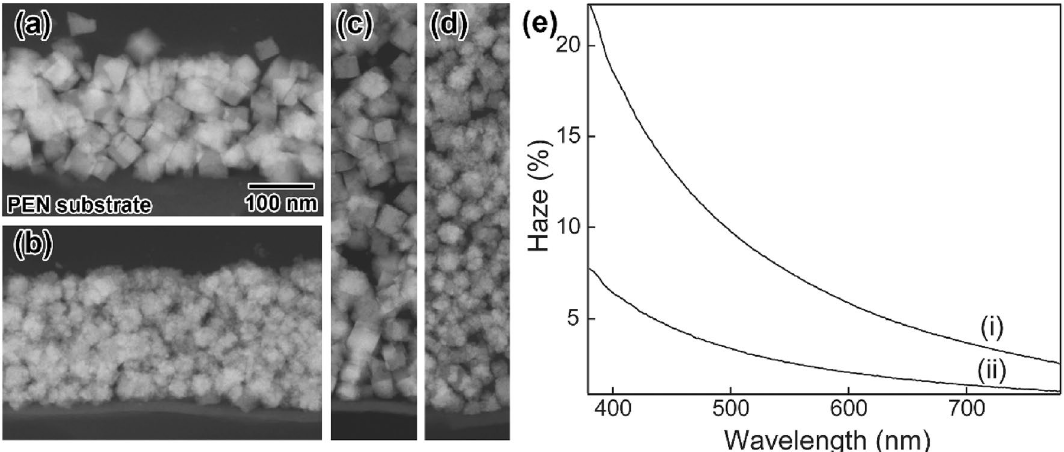
Figure 6. Cross-sectional scanning TEM images of ITO thin films prepared by the NP-mist deposition method using ( a ) C1 and ( b ) P1 on PEN substrates. The thickness was controlled to ca. 200 nm. Corresponding images of the thick films of ( c ) C1 and ( d ) P1 with thicknesses of ca . 500 nm. ( e ) Results of haze measurements of the (i) C1- and (ii) P1 -based thin films on PEN substrates. The scale bar shown in ( a ) is common to ( b )-( d